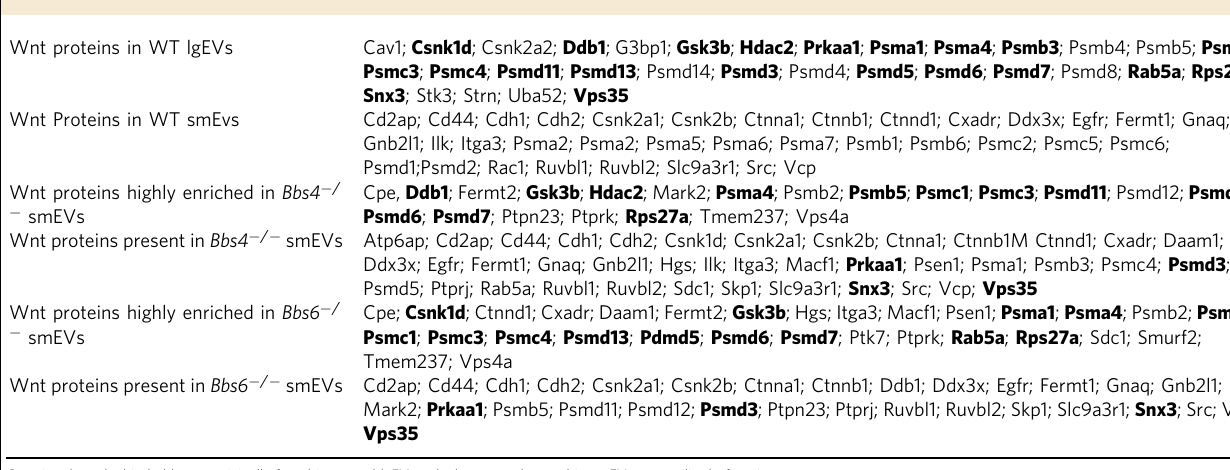
Table 3 Wnt-related proteins, as determined by UniProt or GetGo (uniport.org; getgo.russelllab.org), found inside control and ciliated mutant EVs.